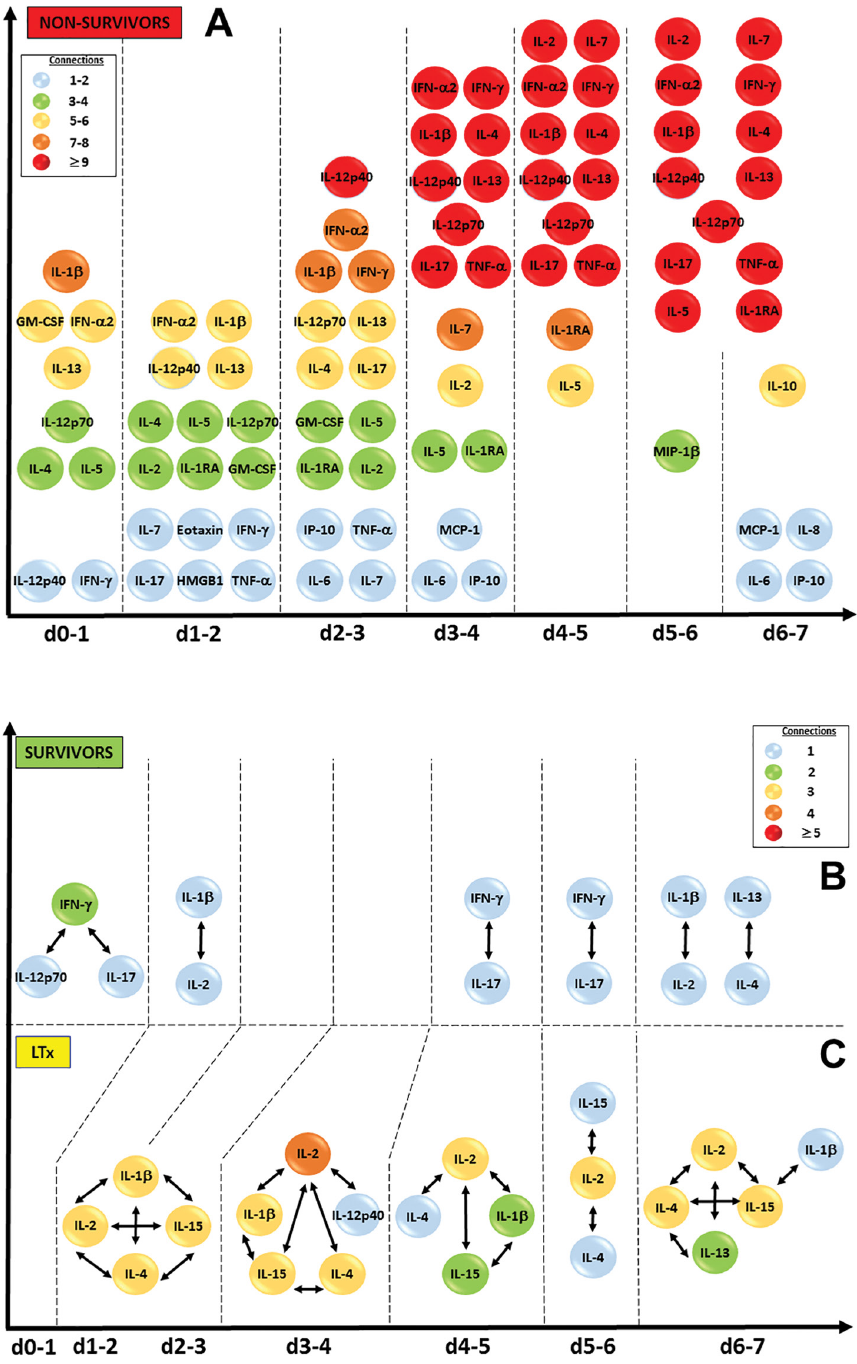
Figure 3. Significant circulating inflammatory mediators and connections in PALF patients (DyNA, high stringency). Circulating inflammatory mediators in serum samples from PALF patients were measured and DyNA (stringency level = 0.95) was performed during seven Methods. Results show the significant mediators based on dynamic patterns and network LTx recipients, n = 28; and panel C: spontaneous survivors, n =